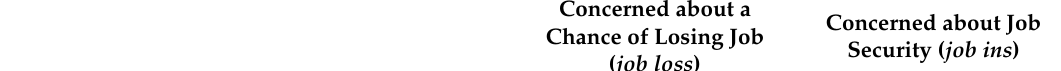
Concerned about Job Security ( job ins